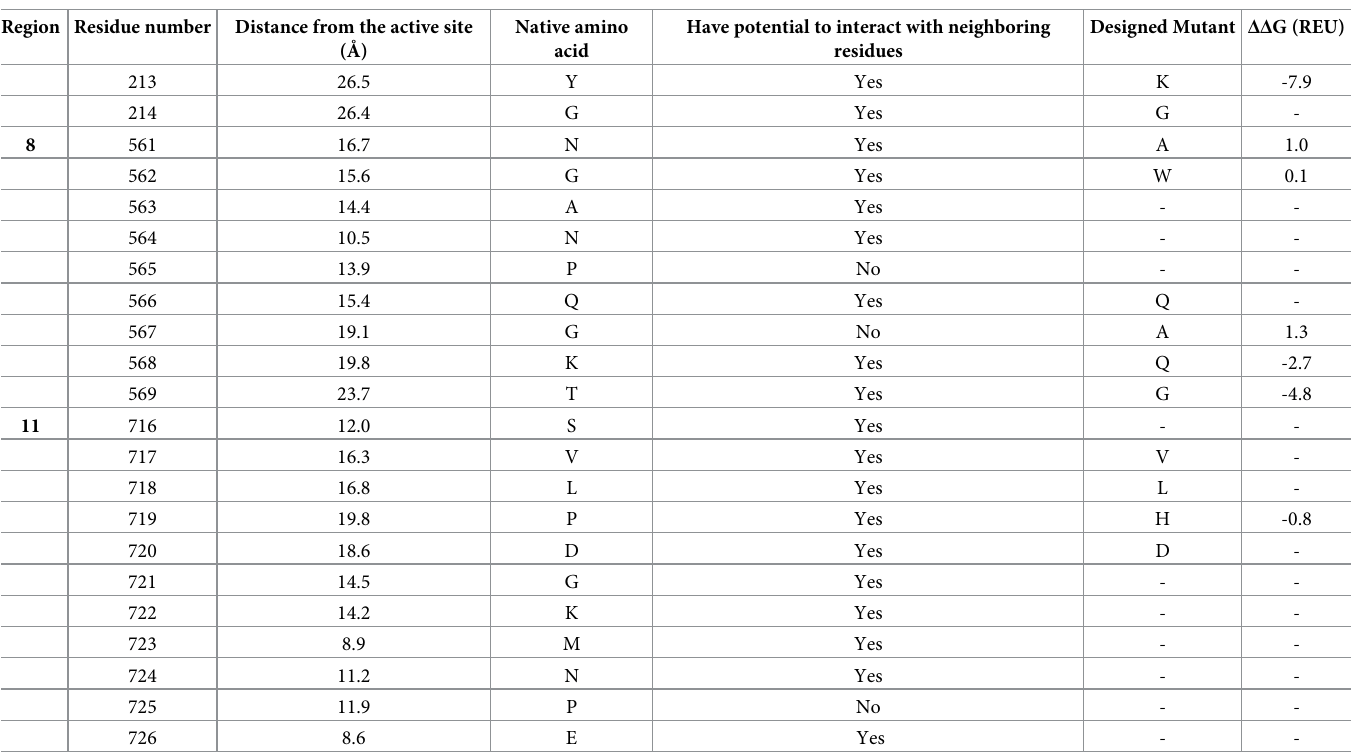
MD simulations were performed on the structures of 21 designed mutants at 500 K in tripli- cates, and the RMSF values of the highly flexible regions of the selected designed mutants were analyzed. As shown in Table 3 and S3 Fig in S2 File, we found that the flexibilities of the designed regions of 14 designed mutants are lower than or similar to those of the wild type. In terms of the flexibilities of designed mutants in region 2, the flexibility of the designed region of the N64G mutant is lower than that of the wild type with the average Δ RMSF values of -9.1 ± 4.7%, while that of S49E (the average Δ RMSF values of -2.5 ± 5.8%) is about the same as that of the wild type. In terms of region 3, the flexibility of the designed region of N88Q is sig- nificantly lower than that of the wild type with the average Δ RMSF values of -18.9 ± 7.1%, while those of T91I and S93A mutants are similar to that of the wild type with the average Δ RMSF values of -0.8 ± 4.7% and -0.6 ± 4.1%, respectively. For region 4, the flexibilities of the designed region of all designed mutants (N202V, G207D, Q209M, T210S, N211T, I212T and Y213K mutants) are lower than that of the wild type with the average Δ RMSF values of -25.4 ± 1.1, -30.6 ± 1.2, -19.4 ± 3.0, -3.5 ± 2.3, -13.8 ± 1.6, -3.0 ± 0.9 and -12.7 ± 0.9%, respec- tively. In terms of region 8, the flexibilities of the designed region of K568Q and T569G mutants are also significantly lower than that of the wild type with the average Δ RMSF values of -15.6 ± 4.0 and -17.5 ± 4.3%, respectively. For region 11, the flexibility of the designed region of P719H mutant is higher than that of the wild type. The eight designed mutants with Δ RMSF values of the highly flexible regions lower than -10.0% (N88Q, N202V, G207D, Q209M, N211T, Y213K, K568Q and T569G mutants) were further simulated at the optimum tempera- ture of the wild type (313 K) in triplicates to determine whether their designed regions,